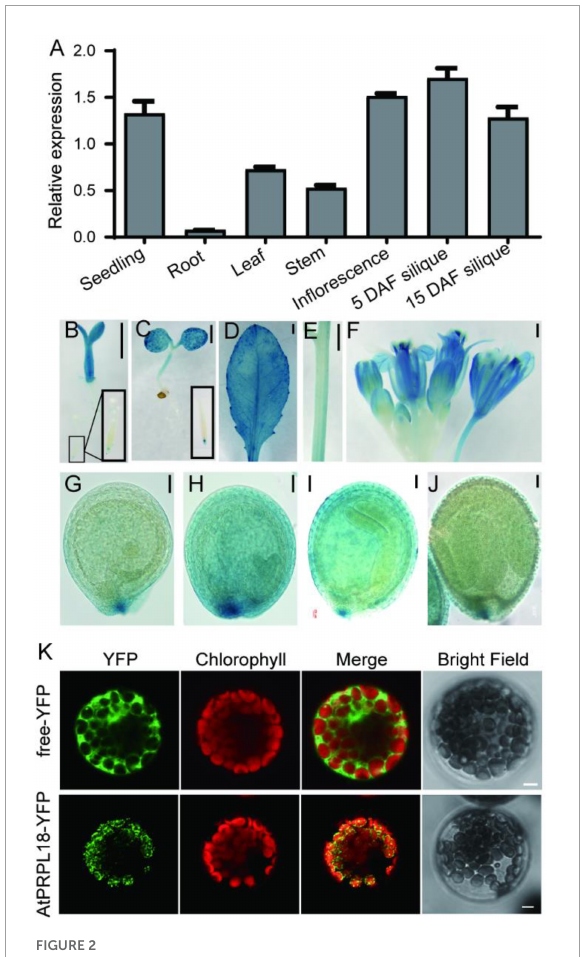
FIGURE2 Gene expression patterns and protein subcellular localization of AtPRPL18. (A) The relative expression of AtPRPL18 in seedling, and stem, mature leaf, inflorescence and siliques from 40-old-day Arabidopsis plants. AtACT2 served as the internal control. Data represent means ± SD ( n = 4). (B–J) GUS staining in the tissues of proAtPRPL18:GUS plants. (B) 3 day-old seedling, (C) 6 day-old seedling, (D) leaf, (E) stem, (F) inflorescence, (G) seeds at globular stage, (H) seeds at heart stage, (I) seeds at torpedo stage, (J) seeds with well-developed embryo.